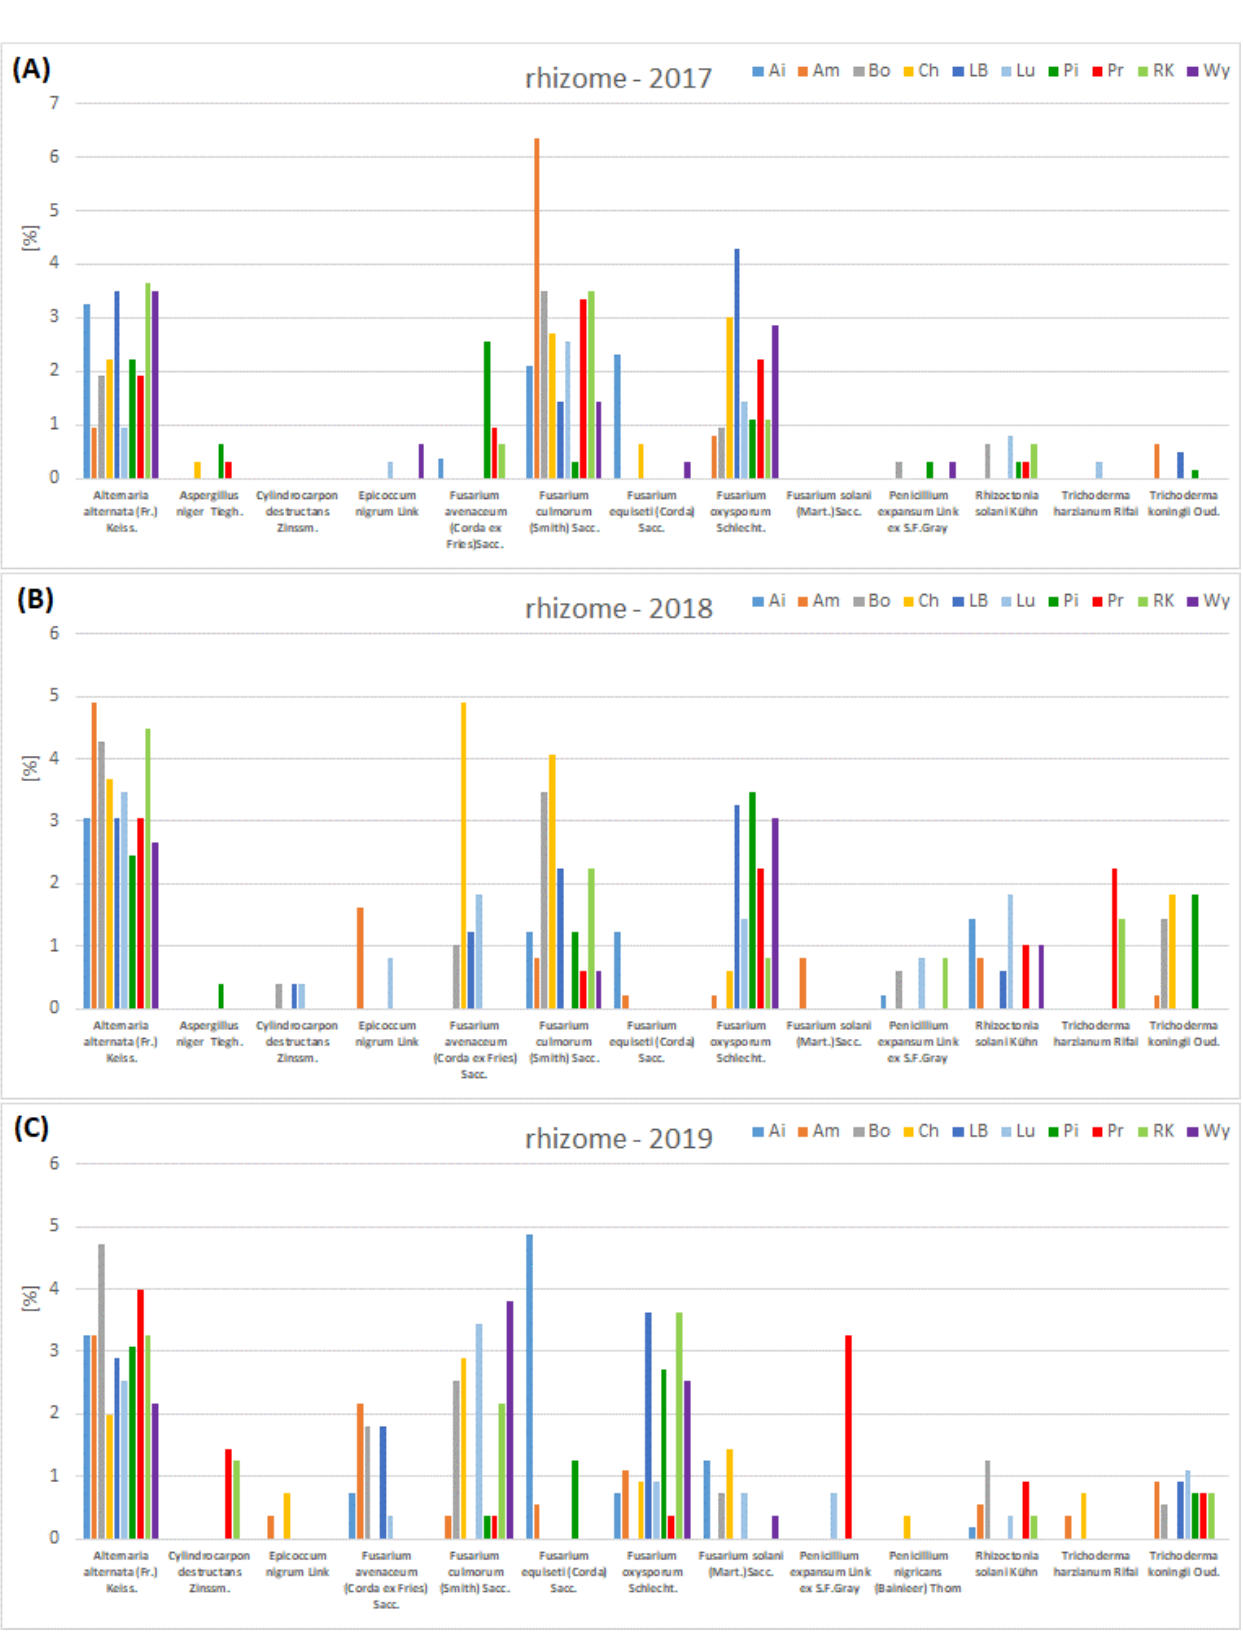
Figure 9. Fungi colonizing rhizome of canna in particular year of studies. Description of cultivars is given in Materials and Methods Section 2.1.